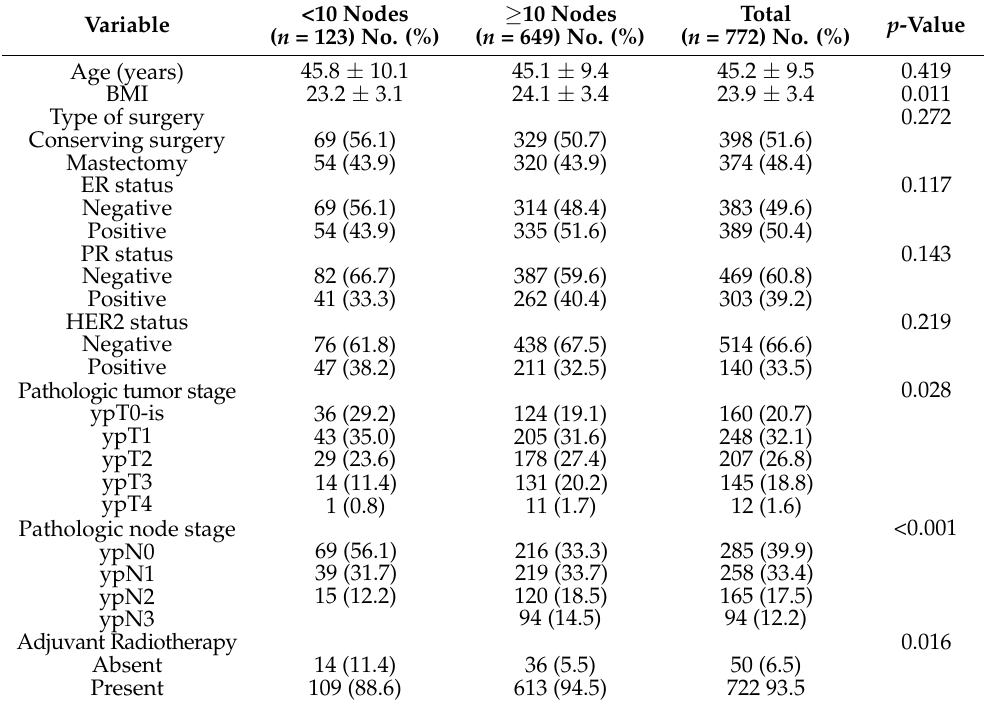
Table 1. Characteristics of the patients’ group according to lymph node number.